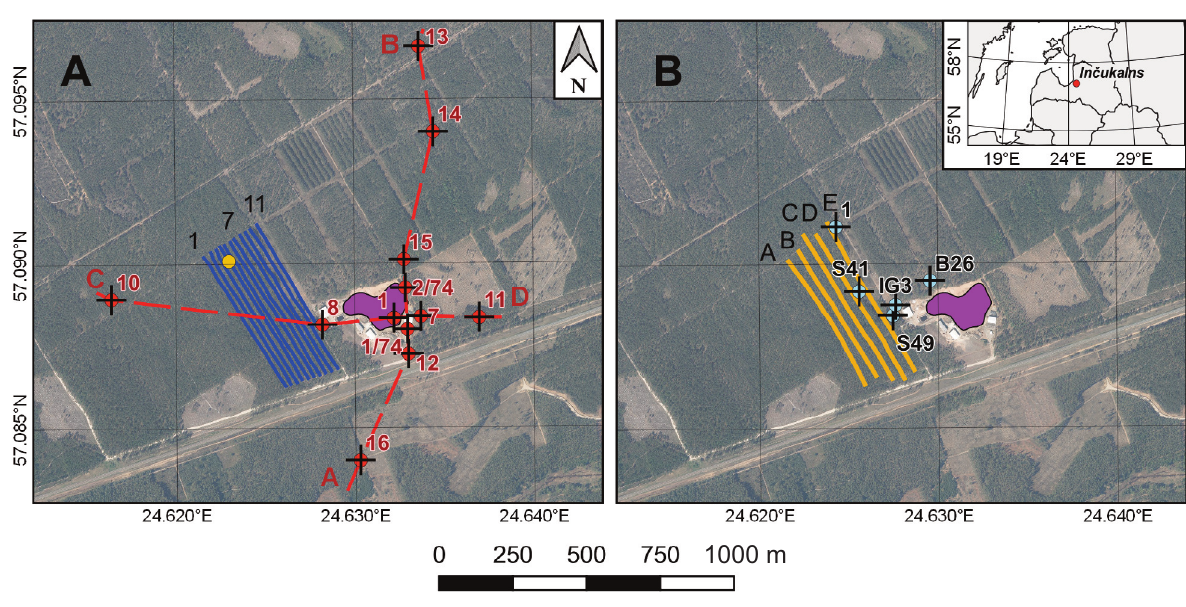
Fig. 1. Overview of the survey area. A , location of the ground-penetrating radar profile lines (blue). The red dashed line marks lines of the geological cross-section. The yellow dot marks the point where common midpoint measurements were done. Black crosses mark the locations of boreholes. The purple polygon marks the acid tar lake. B , location of the electrical resistivity tomography profile lines (yellow). Black crosses mark the locations of groundwater monitoring wells. The purple polygon marks the acid tar